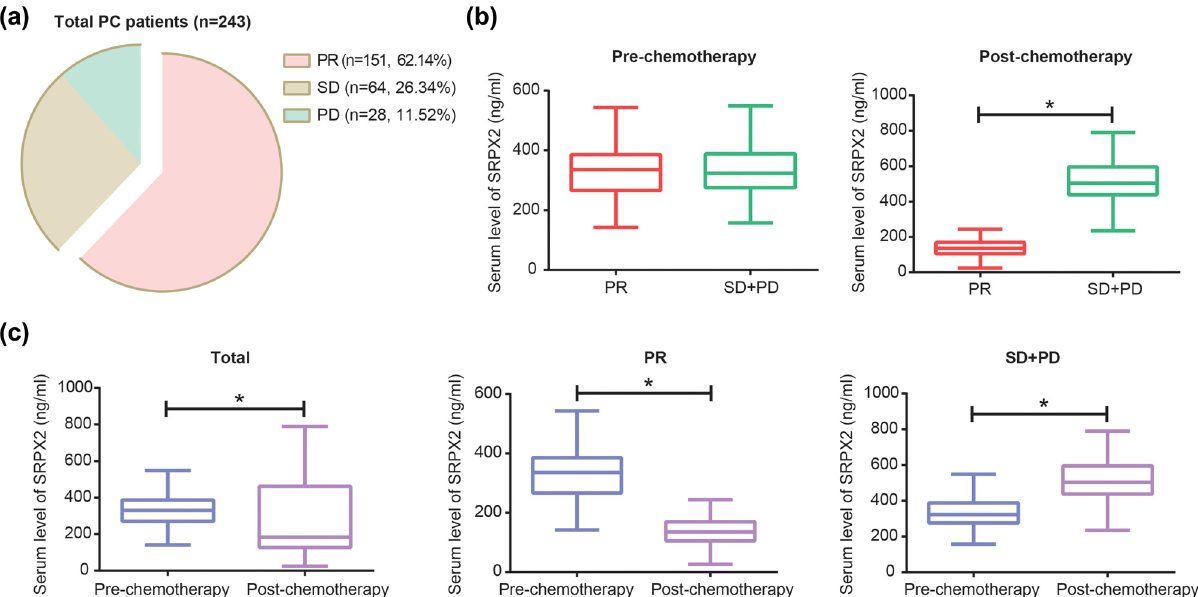
Figure 1: Correlation of SRPX2 with chemotherapeutic e ffi cacy of PC patients. ( a ) The PC patients ( n = 243 ) were tracked as partial remission ( PR, n = 151 ) , stable disease ( SD, n = 64 ) and progressive disease ( PD, n = 28 ) . ( b ) Pre - chemotherapeutic SRPX2 level was compared between PC patients of PR group and ones of SD + PD group, and post - chemotherapeutic SRPX2 level was also contrasted between the two crowds. * P < 0.05. ( c ) Pre - and post - chemotherapeutic SRPX2 levels were compared, respectively, among total PC patients, ones of PR group and ones of SD + PD group. * P <